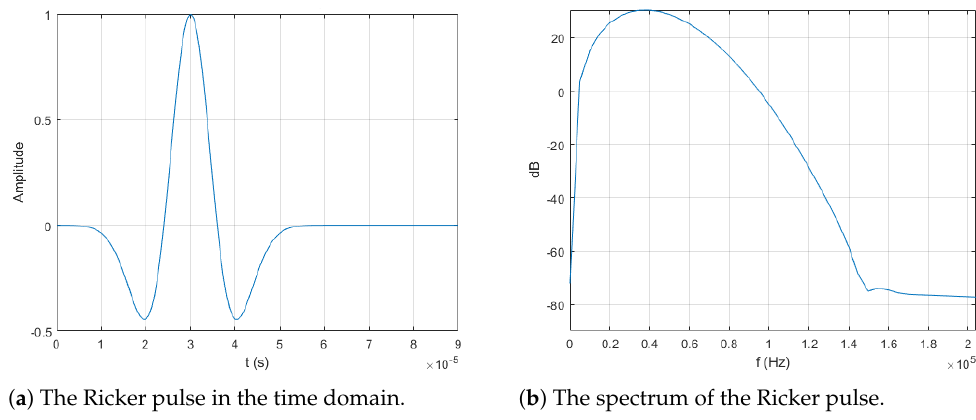
( a ) The Ricker pulse in the time domain. ( b ) The spectrum of the Ricker pulse. Figure 4. The Ricker pulse used in the numerical experiments and its